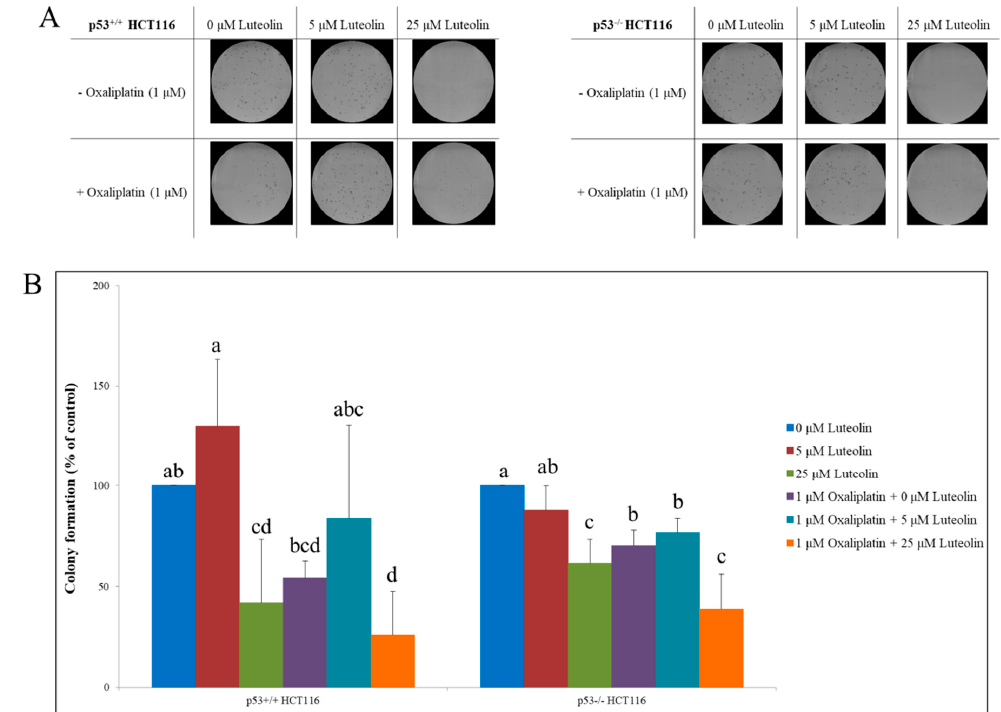
Figure 5. Colony-forming ability of p53 +/+ and p53 -/- HCT116 cells in the presence of luteolin and/or oxaliplatin. Cells were seeded in a 6-well plate and treated with luteolin with or without oxaliplatin for 6 days. (A) Colonies were stained with crystal violet, imaged and counted. Representative images of colonies formed in p53 +/+ HCT116 (left) and p53 -/- HCT116 cultures (right). (B) Relative colony formation ability in HCT116 cells was quantified. Data are expressed as mean ± SD of three independent experiments. A significant difference compared among the groups at p < 0.05 was indicated by different alphabetical letters.